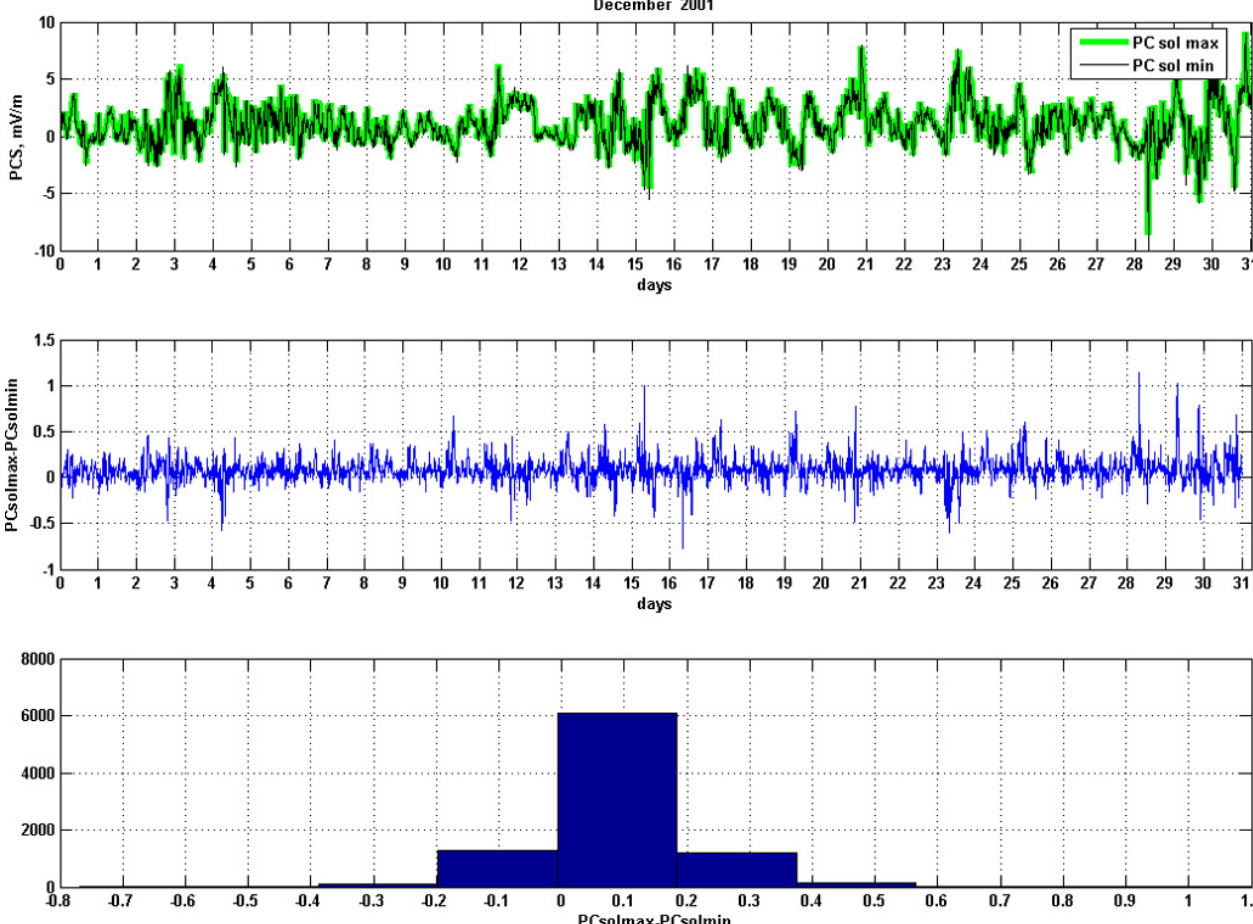
Fig. 6. Indices PC solmax (thick line) and PC solmin (thin line) calculated for Vostok in December 2001 with use of two independent sets of parameters φ , α and β (upper panel), differences between indices PC solmax and PC solmin in a larger scale (middle panel), and distribution plots for the differences (lower